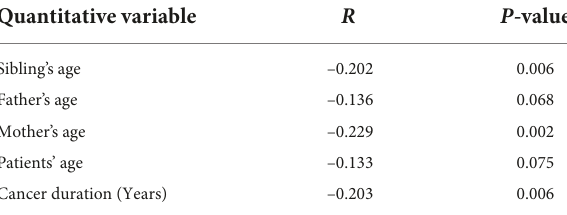
TABLE 3 Bivariate correlation between the unfulfilled psychosocial needs and demographic and clinical quantitative variable. Quantitative variable R P -value